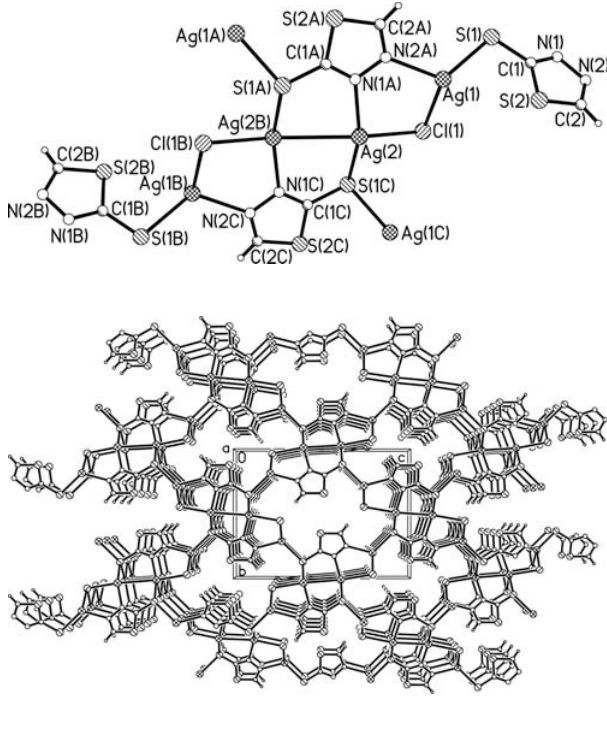
Table 1. Data collection and handling.